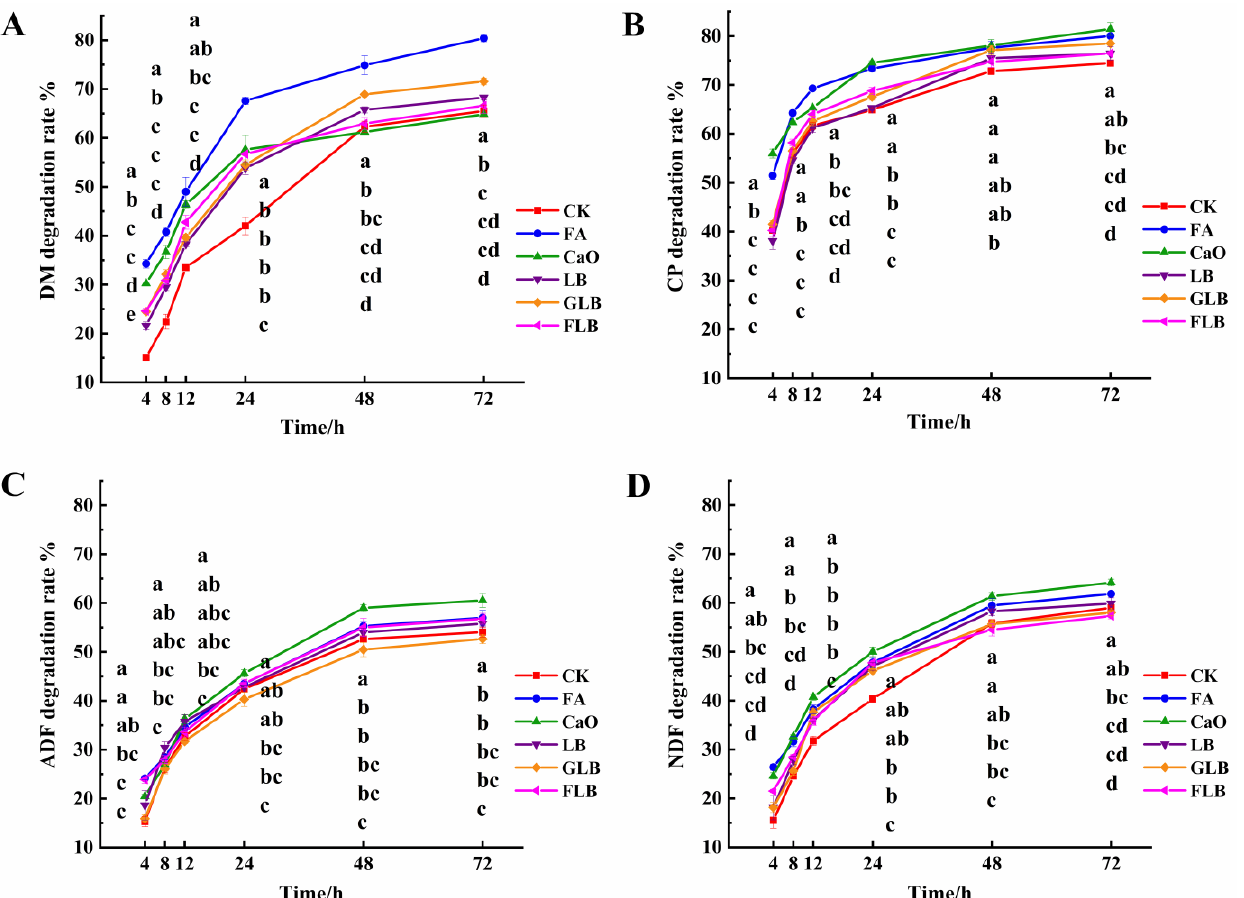
Figure 7. The rumen degradations of DM, CP, NDF, and ADF in alfalfa silage. Means with different letters at the same time differ from each other ( p < 0.05); values are means ± SE; DM, dry matter; CP, crude protein; NDF, neutral detergent fiber assayed with a heat-stable amylase and expressed inclusive of residual ash; ADF, acid detergent fiber expressed (inclusive of residual ash); CK, control, no additive; FA, 0.6% formic acid; CaO, 3% calcium oxide and 3% urea; LB, 1 × 10 6 cfu/g L. buchneri ; GLB, 2% glucose and 1 × 10 6 cfu/g L. buchneri ; FLB, 2% fucoidan and 1 × 10 6 cfu/g L. buchneri . Table 4. Ruminal degradation kinetics of DM, CP, NDF, and ADF of alfalfa silage.